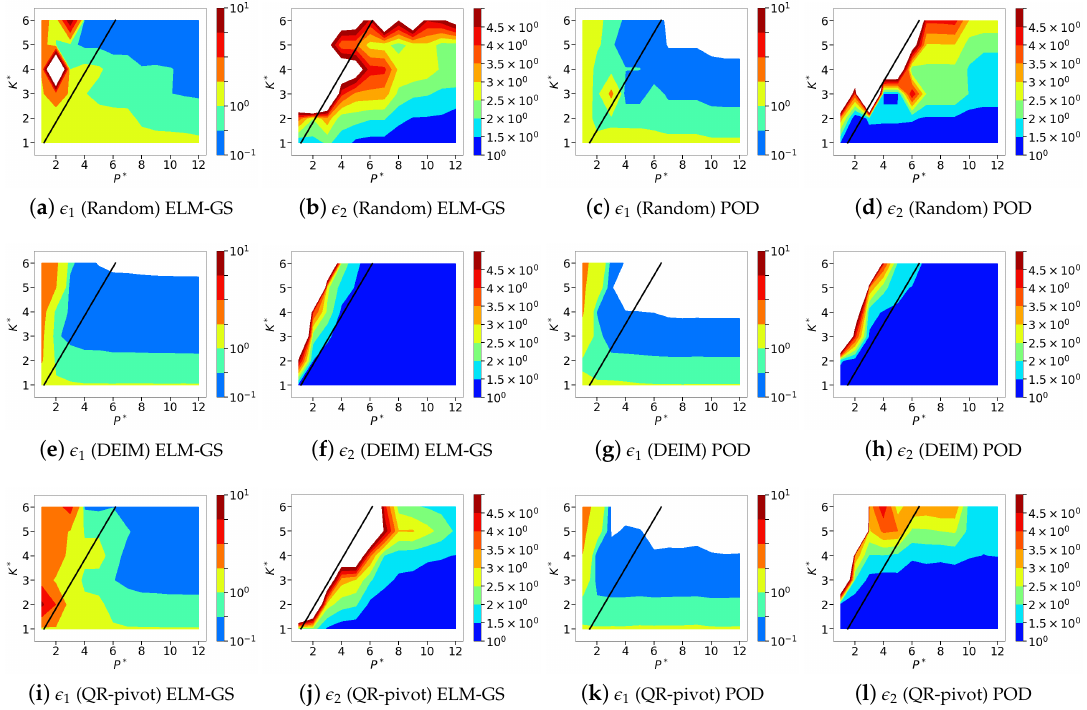
Figure 13. Isocontours of the normalized mean squared ELM-GS ( a , b , e , f , i , j ) and POD-based ( c , d , g , h , k , l ) sparse reconstruction errors ( l 2 norms) using DEIM (top row), QR-pivoting (middle row) and random (bottom row) sensor placements for cylinder wake data. Left: normalized absolute error metric, (cid:101) 1 . Right: normalized relative error metric, (cid:101) 2 . The black line corresponds to P ∗ = K ∗ and separates the over-sampled form under-sampled